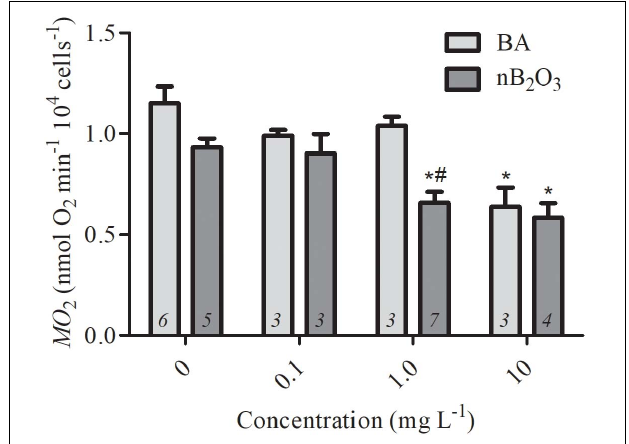
FIGURE 2 | Rates of oxygen consumption ( ˙M O 2 ) of Oncorhychus mykiss hepatocytes exposed to varying concentrations of BA and nB 2 O 3 . Data are presented as mean ± SEM and sample size is indicated within each bar. * Indicates significant difference from the corresponding control group and # indicates significant difference from BA-treated group of the same